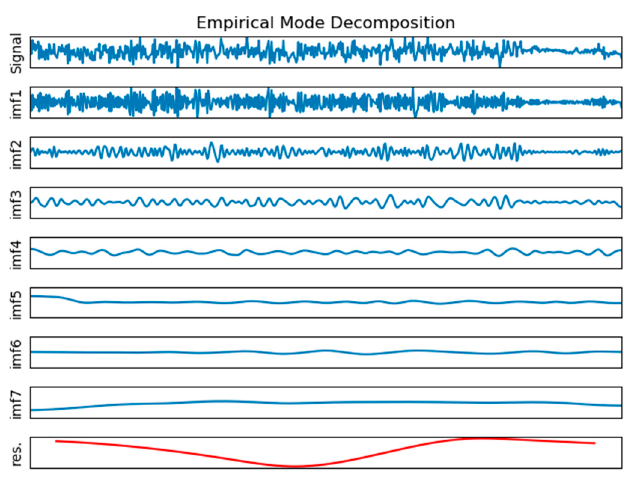
Figure 10. The result of EMD decomposition.